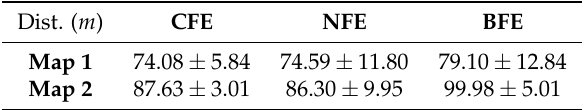
Table 3. Comparison of distance traveled in the two